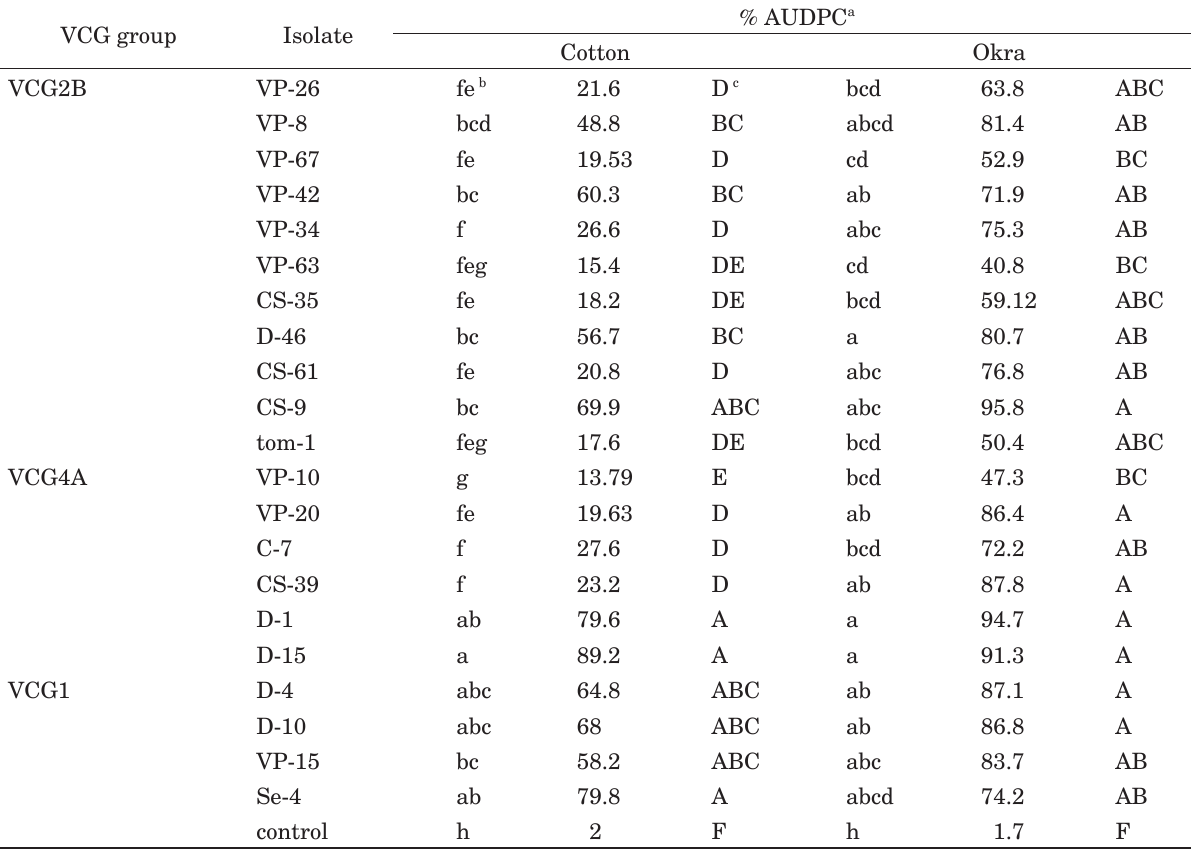
Table 5. Virulence of Verticillium dahliae isolates from each vegetative compatibiliy group (VCG) to cotton and